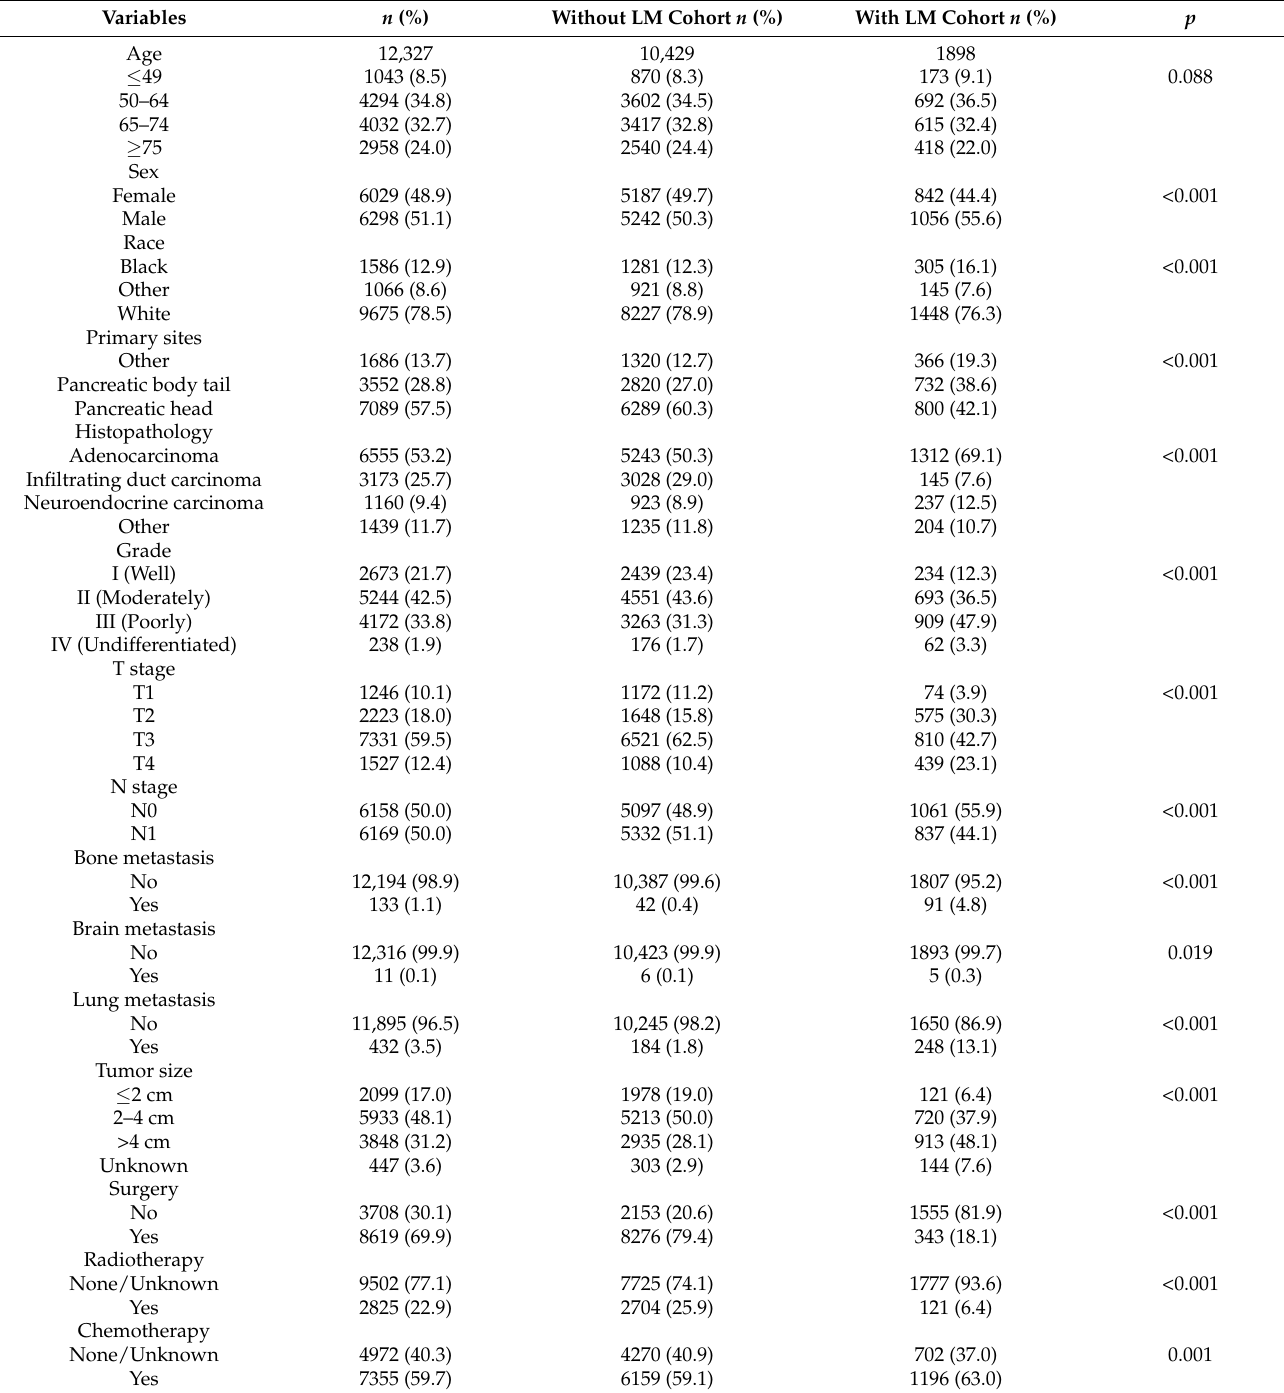
Table 1. Baseline clinical features and treatment regimens in 12,327 patients with pancreatic